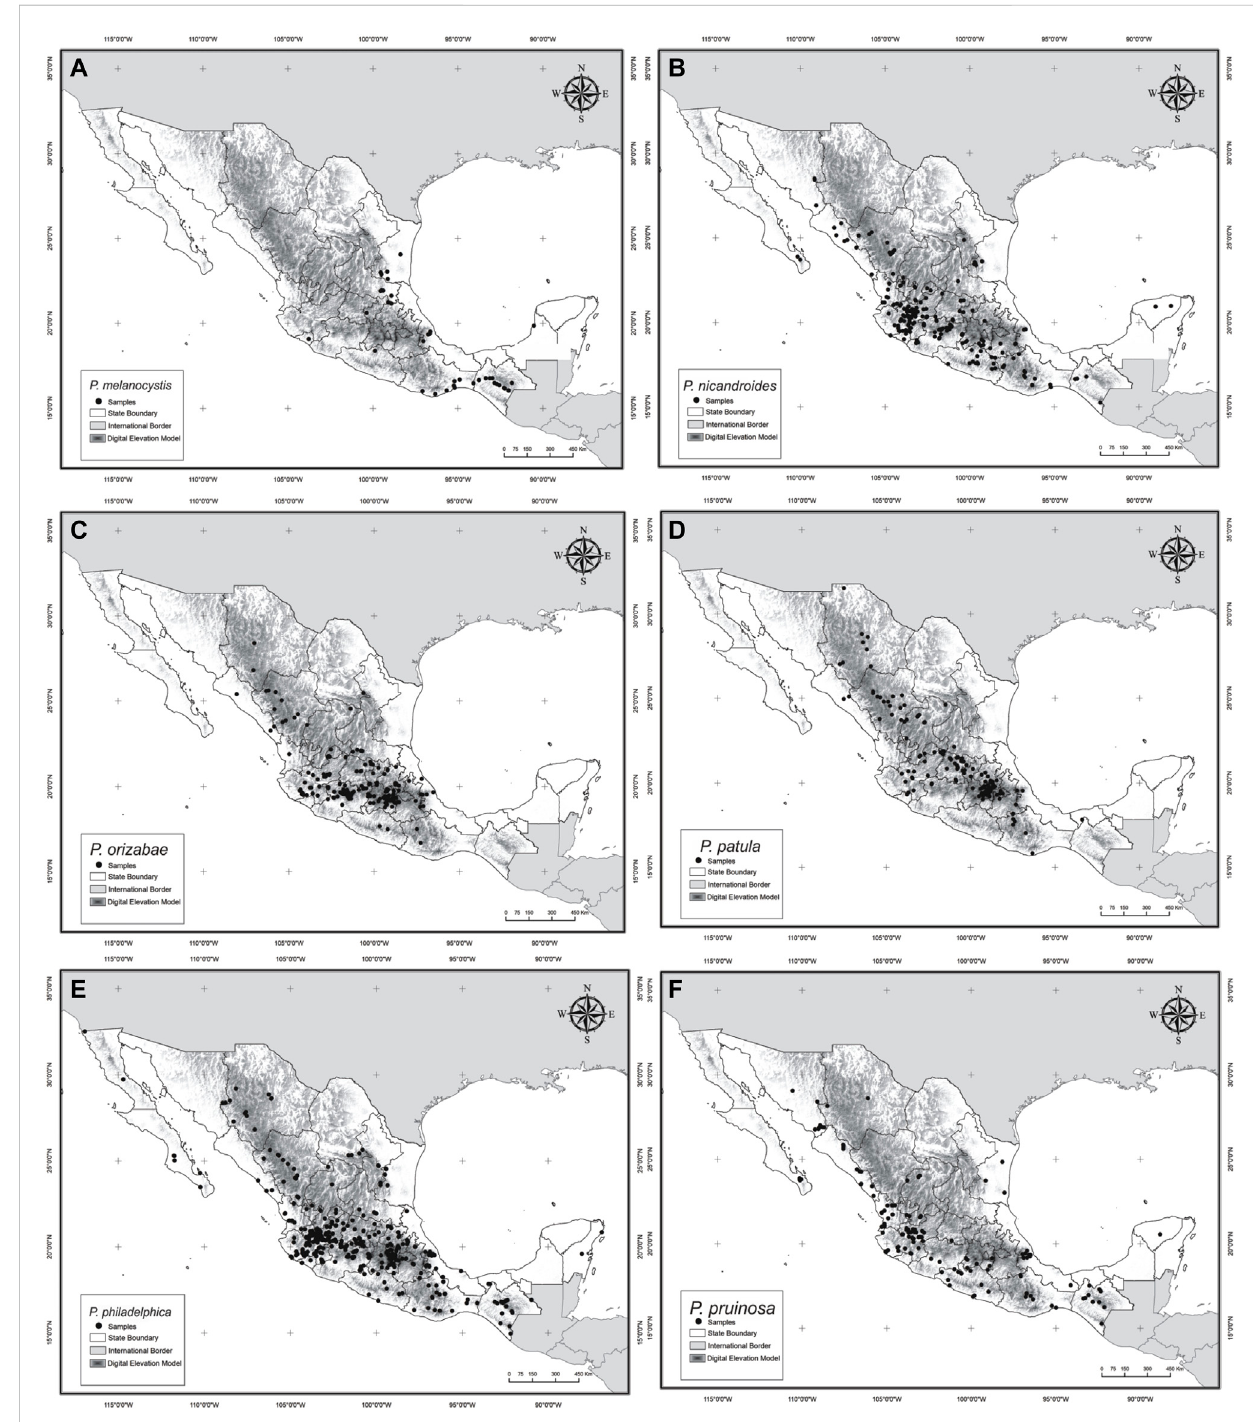
Geographic distribution of Physalis spp. (A) P. melanocystis , (B) P. nicandroides , (C) P. orizabae , (D) P. patula , (E) P. philadelphica , (F) P.